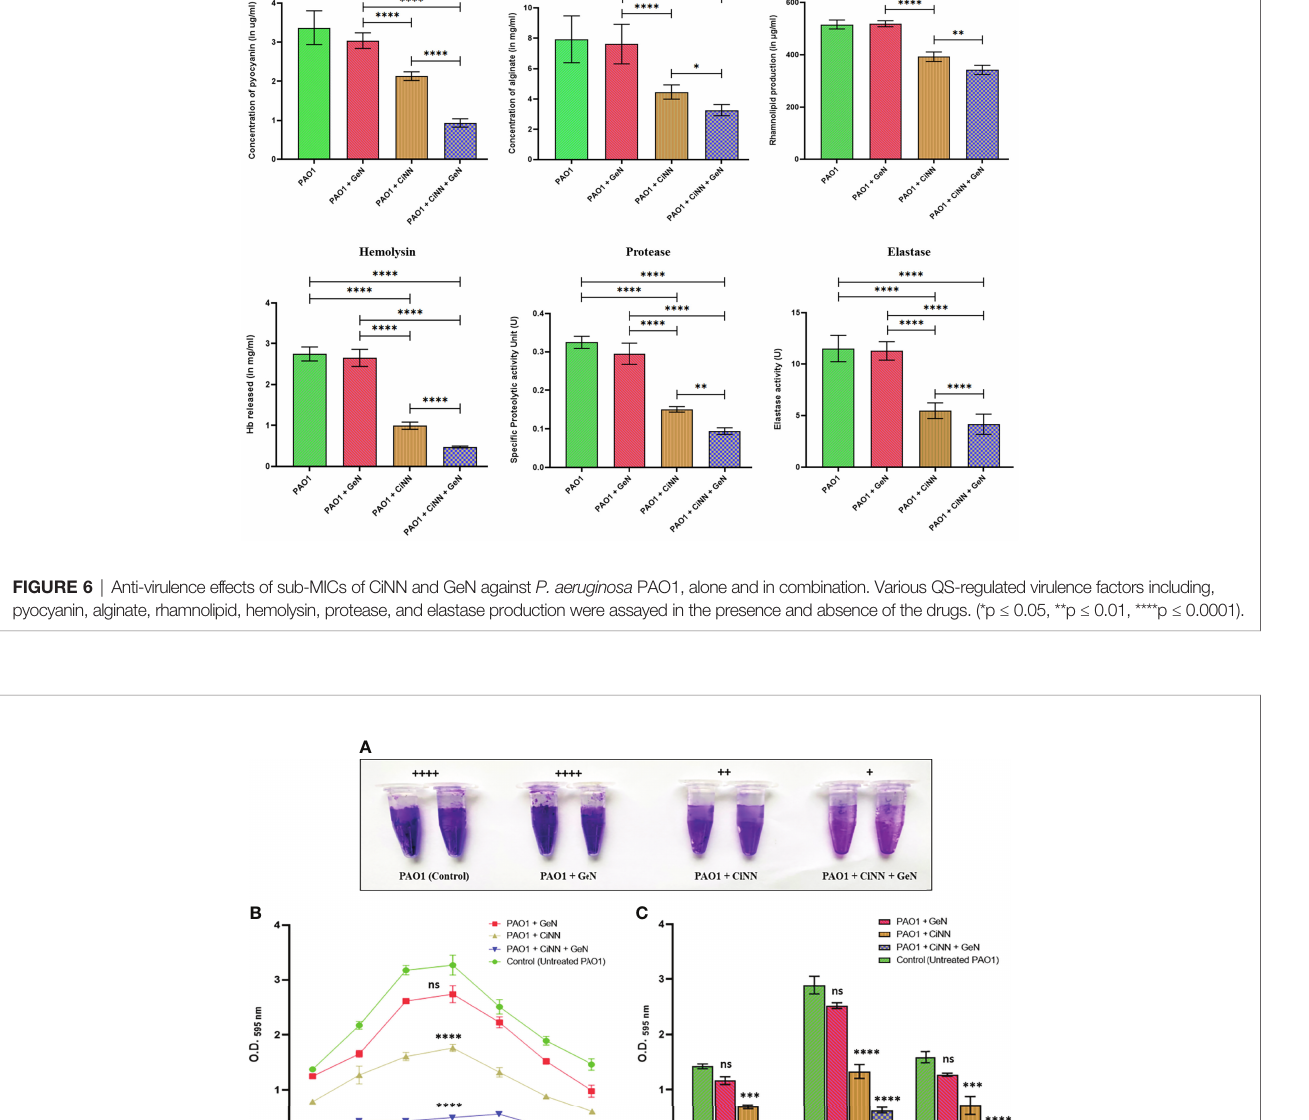
and eradicating preformed bio fi lms of P. aeruginosa PAO1 in